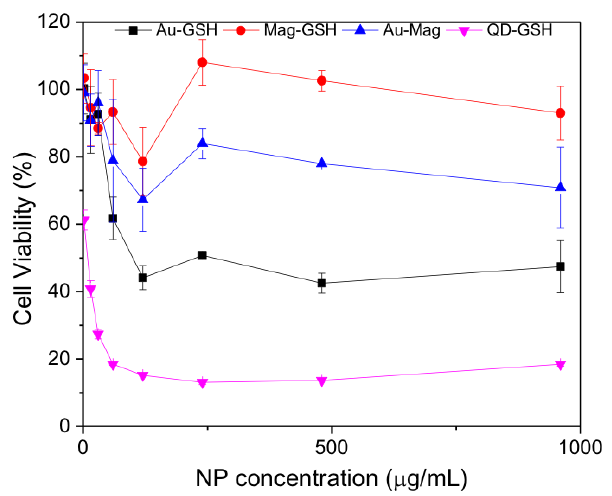
Figure 11. MTT cell viability assay for Jurkat tumor cells incubated with the indicated NP at 1.5; 15; 30; 60; 120; 240; 480 and 960 μg/mL. Percentage of viable cells, as compared to cells cultured in the absence of NP (considered as 100% viability), is shown. Mean values and standard error for three experiments are shown. Viability of cells cultured in the presence of 10% dimethyl sulfoxide (DMSO) is 8.79%.